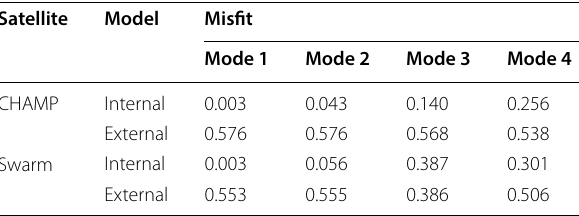
Table 1 Normalised misfit values comparing PCA modes with internal and external SH models, for